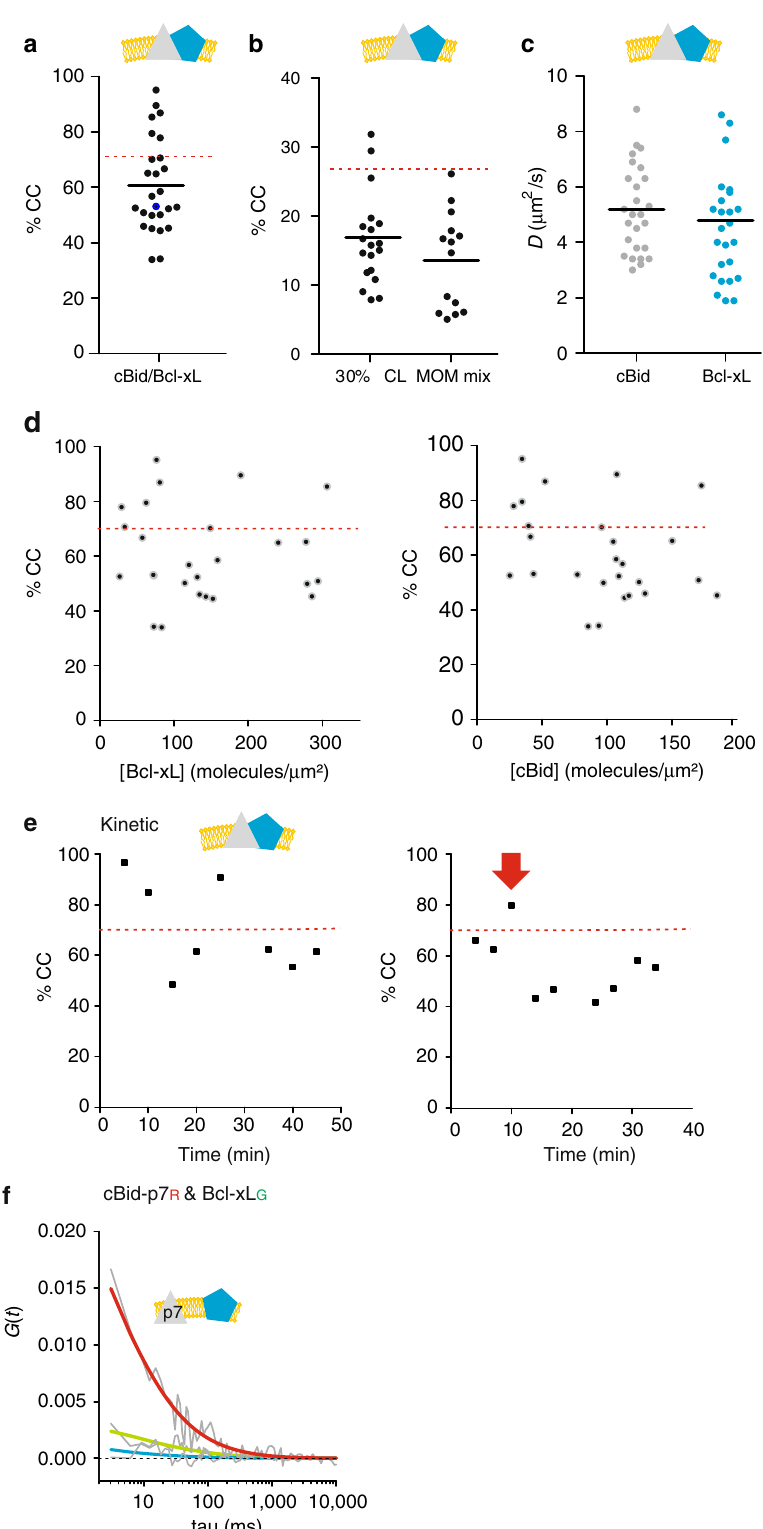
Fig. 5 Quantitative analysis of cBid-Bcl-xL association in membranes. a %CC between cBid G and Bcl-xL R in membranes (30% CL; n = 5). b %CC between cBid G and Bcl-xL R in GUV membranes comparing both lipid mixtures ( n = 3). c D of cBid G and Bcl-xL R in individual 30% CL GUVs ( n = 5). d %CC vs. the cBid G or Bcl-xL R protein concentration in GUVs (30% CL; n = 5). e Evolution of %CC between cBid G and Bcl-xL R in two individual GUVs as a function of time. The red arrow marks the time point at which the GUV was permeabilized (see also Supplemental Fig. 9). f Representative FCCS graph of cBid p7R and Bcl-xL G interaction. The absence of positive CC indicates that the labeled proteins do not interact in the membrane ( color code as in 4 A). In a , d , and e , the dotted red line indicates the maximal CC considering dimer formation and degree of labeling. FCCS fl uorescence cross correlation spectroscopy